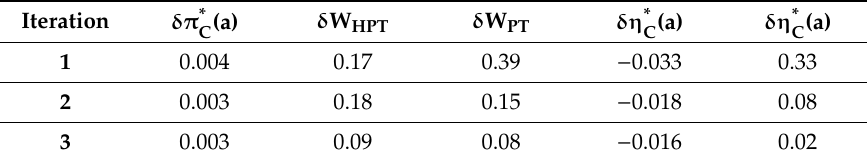
Table 3. Corrections for three first iterations.